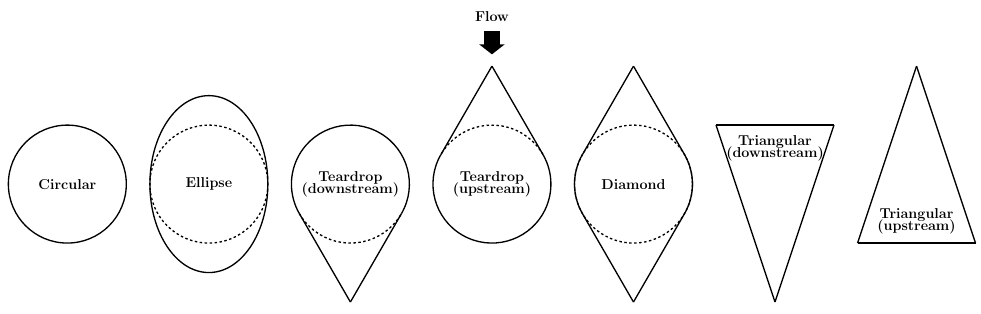
Figure 2. Popular variants of the dimple shape.